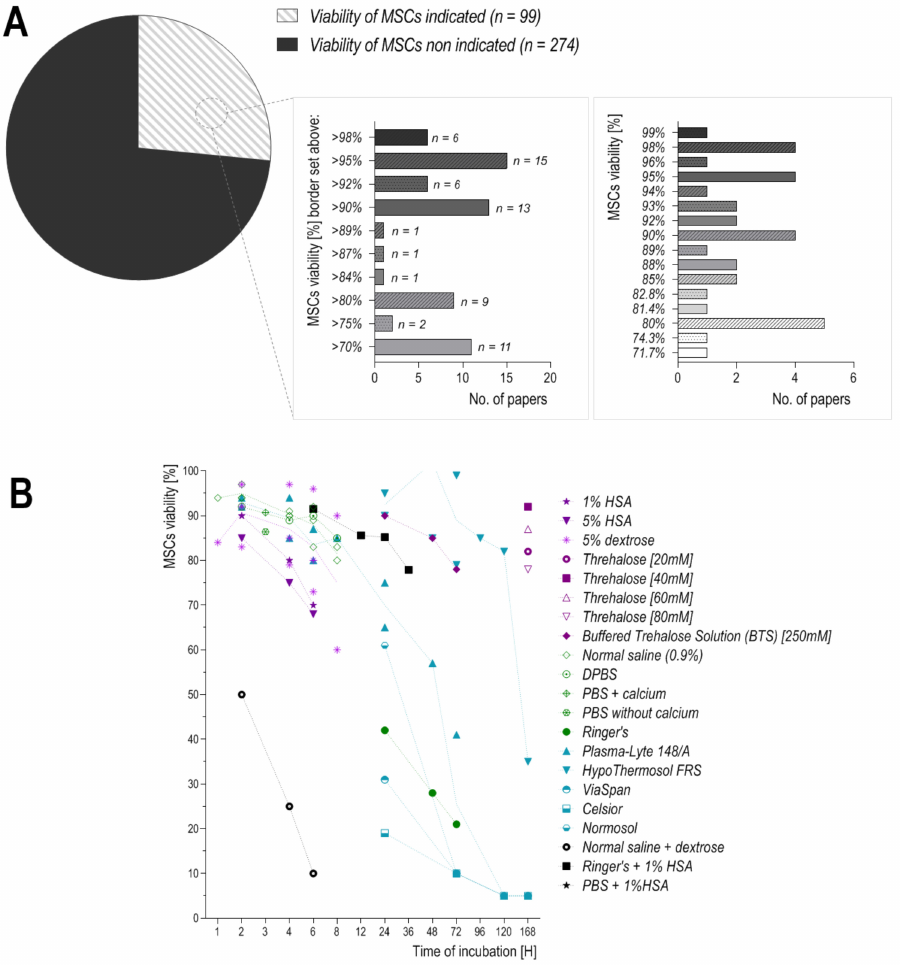
Figure 3. Summary of the results obtained from the literature search. ( A ) MSC viability shown as the minimum level required (left graph) or actual viability at implantation (right graph), ( B ) viability of MSCs incubated in different storage solutions, measured up to 168